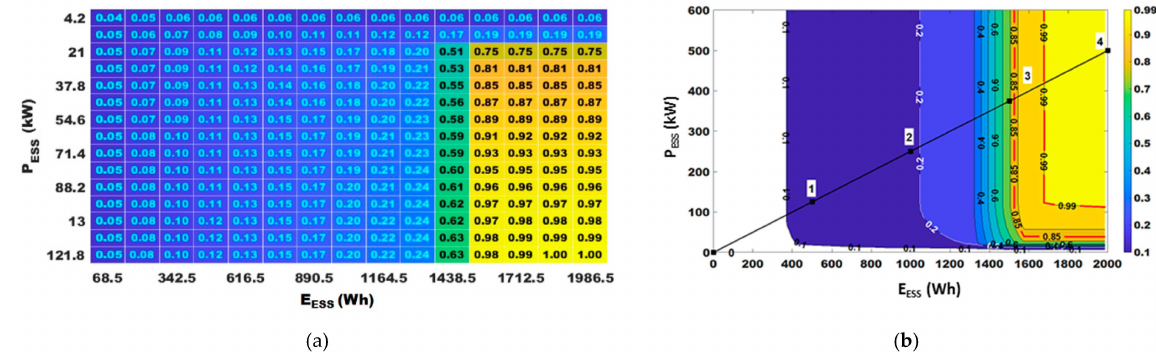
Figure 14. ( a ) Cumulative power and energy distribution function in the ESS and ( b ) cumulated distribution function for selection of the number of cabinets necessary to cover a certain number of cases of the proposed objective.